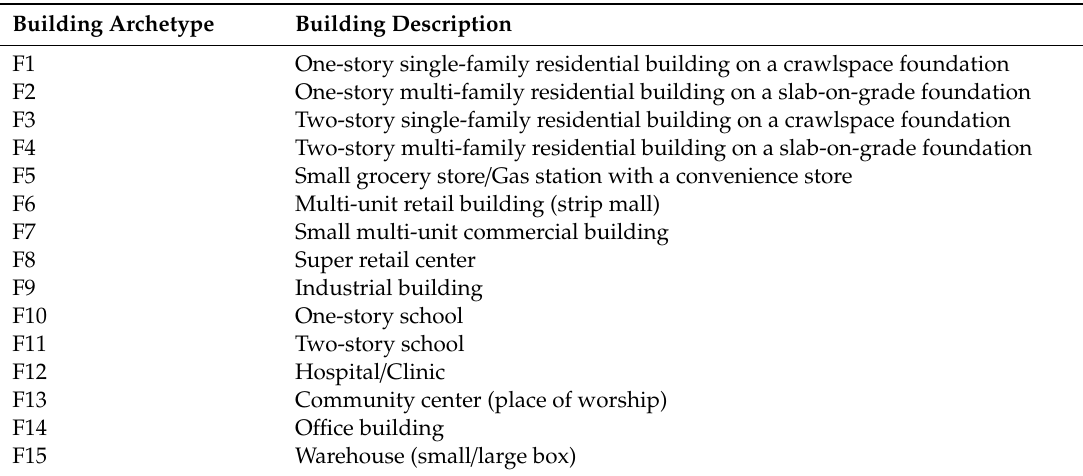
Figure 5. Components’ results for the F10 one-story school building archetype: ( a ) Components’ fragility curves; ( b ) Components’ loss curves.